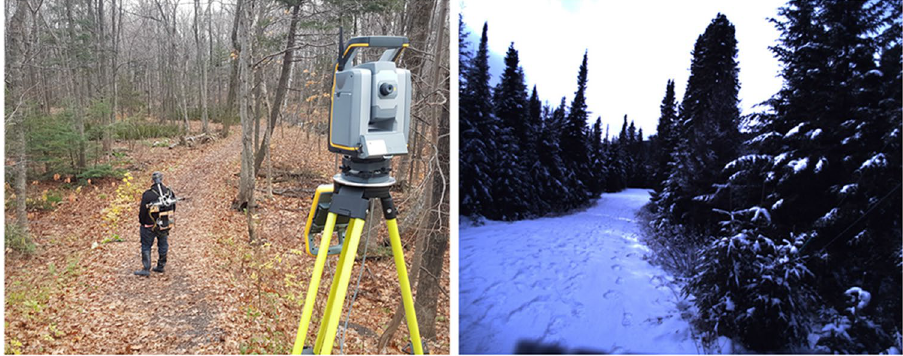
Fig. 6 Data acquisition in forestry